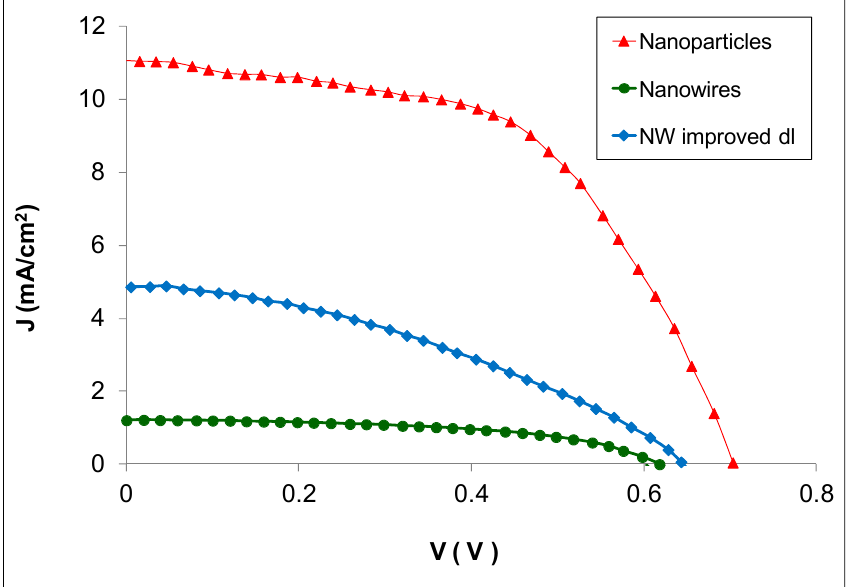
Figure 5. J-V characteristics of ZnO nanoparticle, nanowire and nanowire with improved dye loading DSSCs.